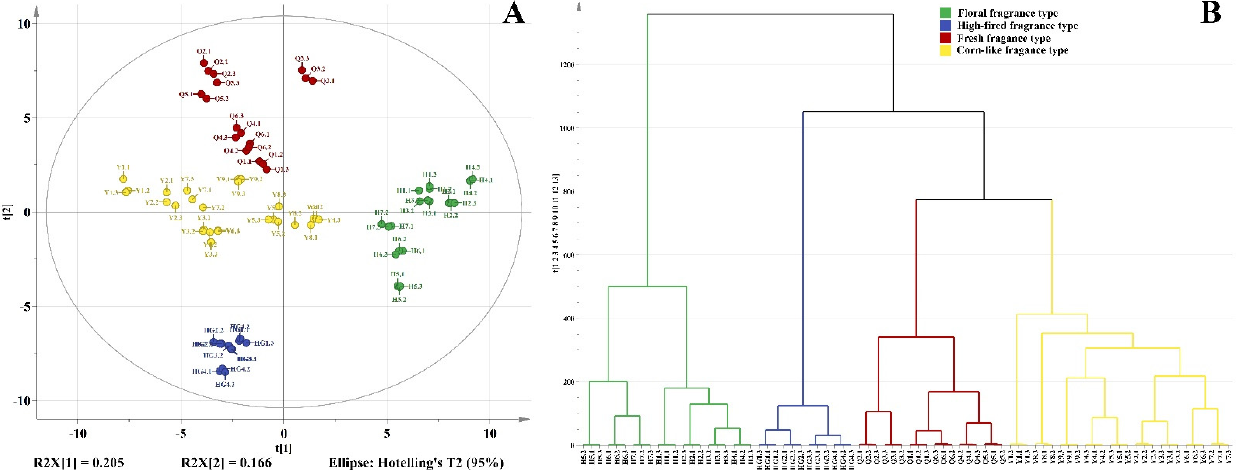
Figure 2. PCA ( A ) and HCA ( B ) of the different aroma types of yellow teas.